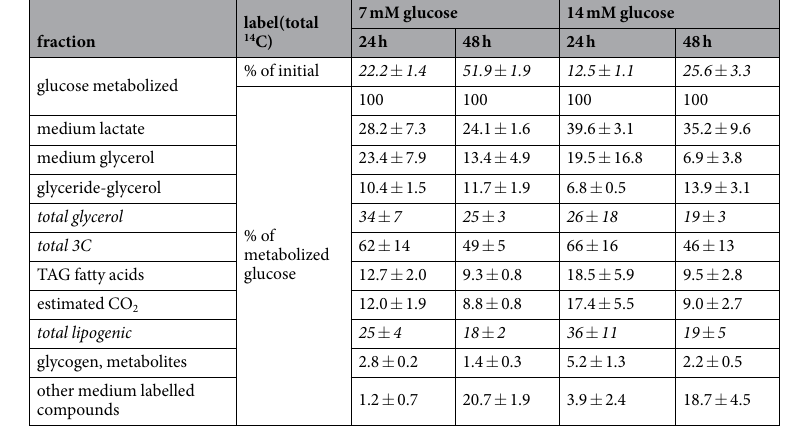
Table 2. Percent distribution of label from metabolized initial glucose in the main metabolite fractions of rat epididymal adipocytes in primary culture. Values calculated using only the “labelled” well data. Total glycerol corresponds to the sum of the label in medium free glycerol plus acyl-glycerides-glycerol. Statistical significance of the differences between groups (2-way ANOVA). Total “lipogenic” label includes that of cells esterified fatty acids and the calculated minimum CO 2 needed for their synthesis as explained in the text. The effect of “incubation time” was significant for glucose metabolized (P T < 0.0001), glycogen (P T = 0.0087) and for other medium labelled compounds (P T < 0.0001), whereas the significance of “initial glucose concentration” affected only the glucose metabolized (P G < 0.0001). No significant interactions were observed except for metabolized glucose (P i = 0.0021).